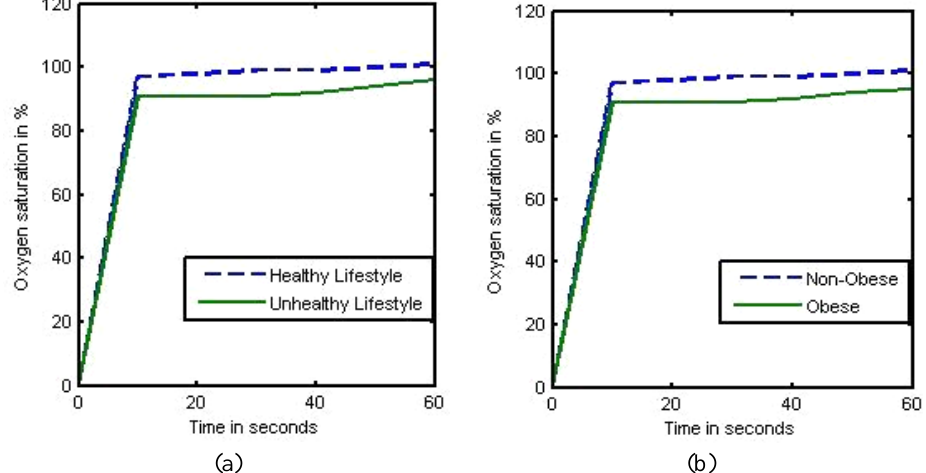
Figure 9. (a) Healthy lifestyle versus unhealthy lifestyle, and (b) non-obese versus